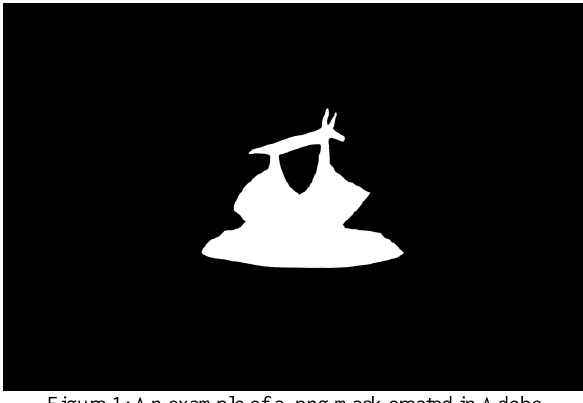
Figure 1: An example of a .png mask created in Adobe Photoshop